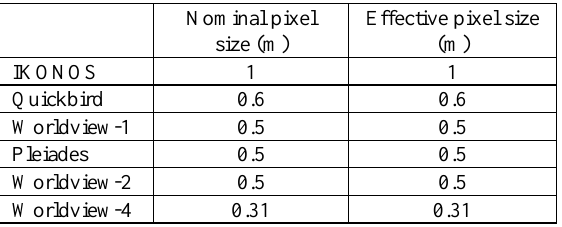
Table 1. Nominal and effective GSD determined by edge